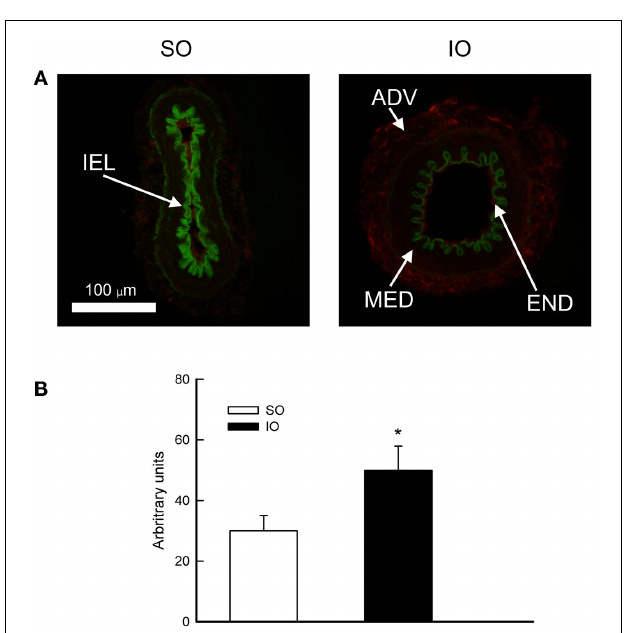
FIGURE 3 | (A) Representative photomicrographs and (B) quantification of collagen I/III immunofluorescence of confocal microscopic sections of mesenteric resistance arteries from SO and IO rats. ADV, adventitial layer; END, endothelial layer; MED, media layer; IEL, internal elastic lamina; ROI, region of interest (marked with a dotted white line). (C) Confocal projections of the IEL and (D) quantitative analysis of total number of fenestrae in the IEL